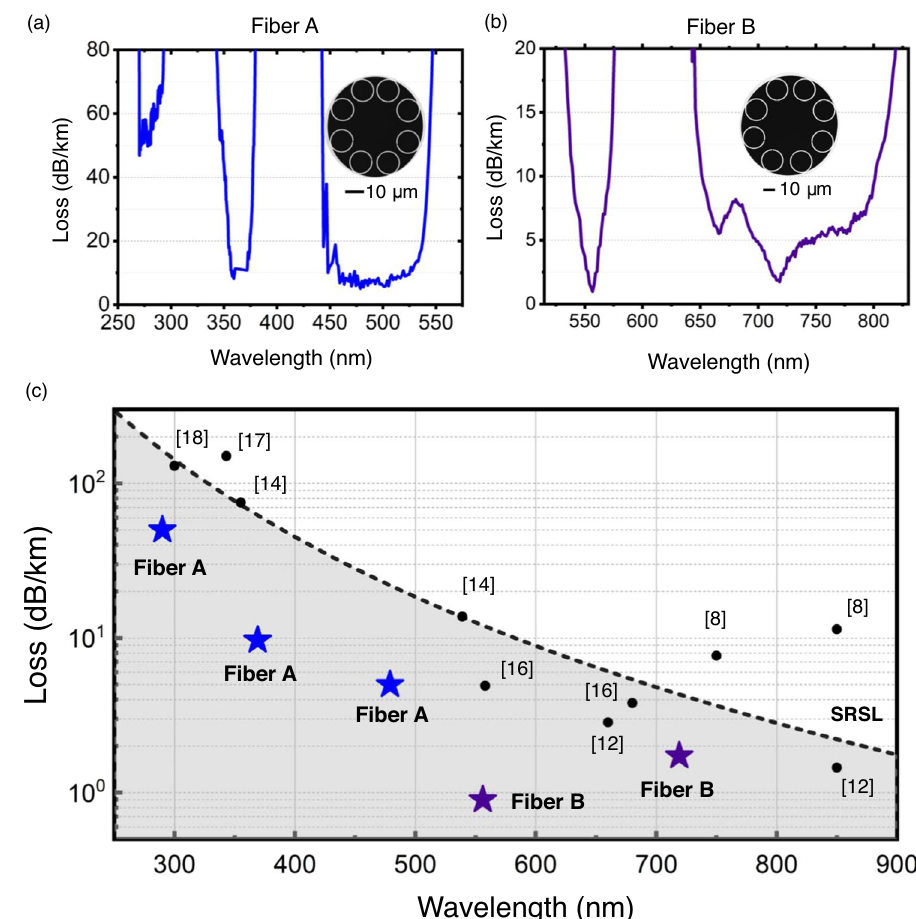
Fig.5|Recordlow-lossHCPCFsfortheshort-wavelengthrange. Lossmeasurementresultsfor a FiberAand b FiberBandthe fi bers ’ cross-sections. c ICHCPCFstate-of- the-art framework and the SRSL